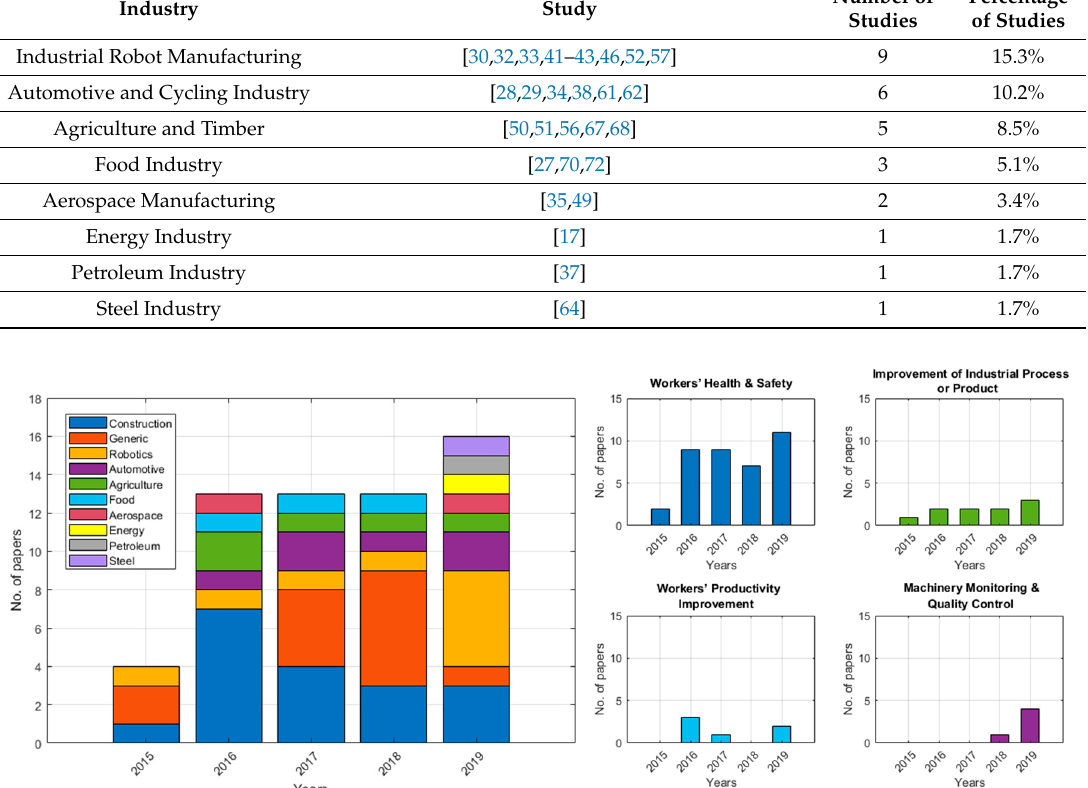
Figure 3. Number of publications per year and type of industry sector ( left ) and application ( right ).